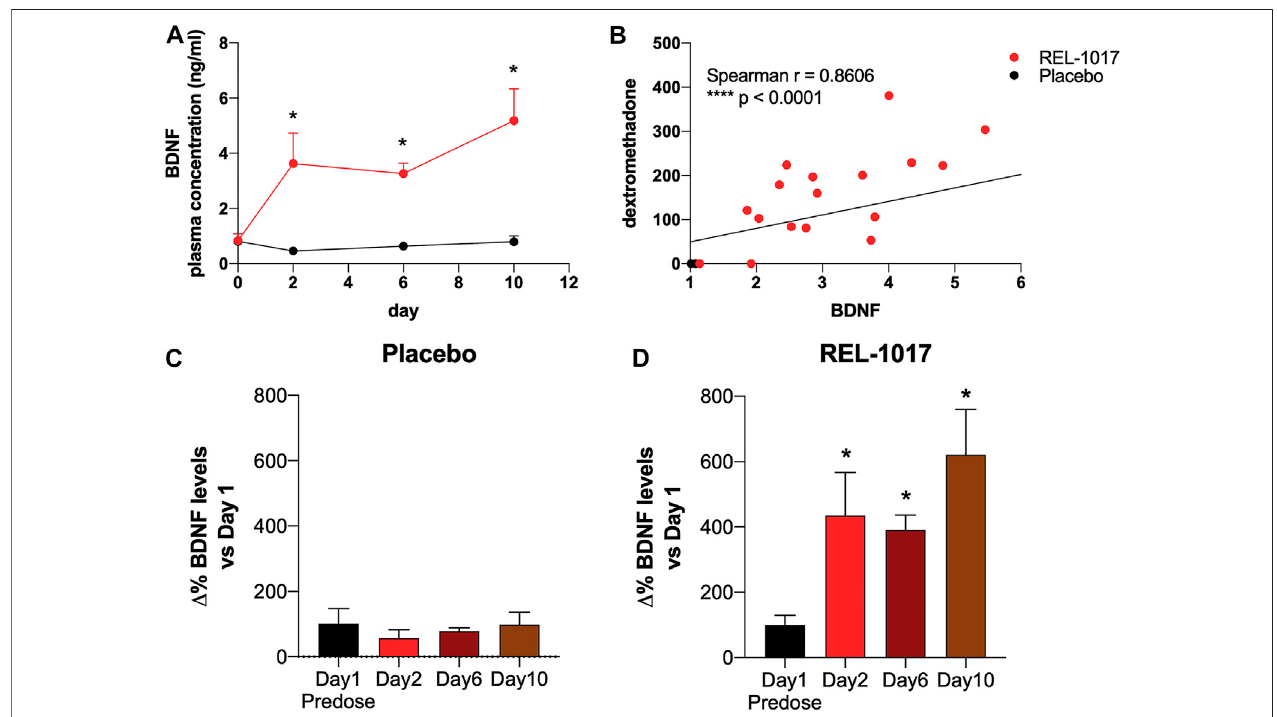
FIGURE 1 | (A) Plasma BDNF concentration in placebo (black line) and REL-1017-treated (red line) subjects. p < 0.05 vs. placebo at the same time point. (B) Spearman correlation between REL-1017 and BDNF plasma concentrations. (C) Percentage changes in BDNF levels in placebo subjects. (D) delta changes in BDNF levels in treated subjects. * p < 0.05 vs. Day 1